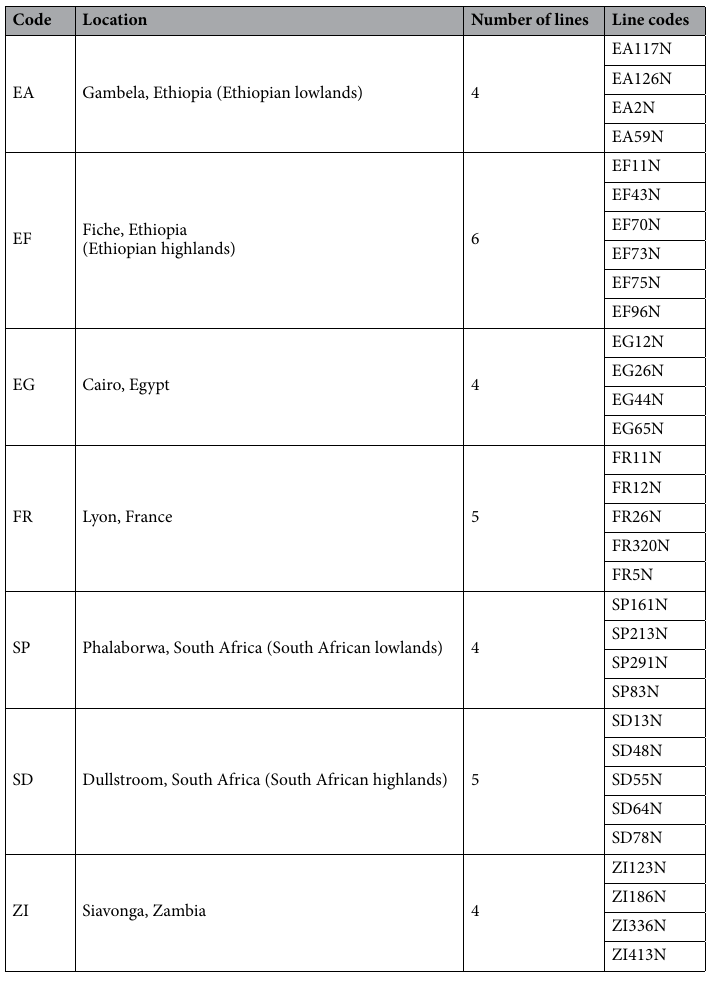
Table 1. Origins of the Drosophila melanogaster populations previously used by Pool et al. (2017). These lab- reared populations comprise multiple isofemale lines, each derived from a female fly captured in the wild in one of seven